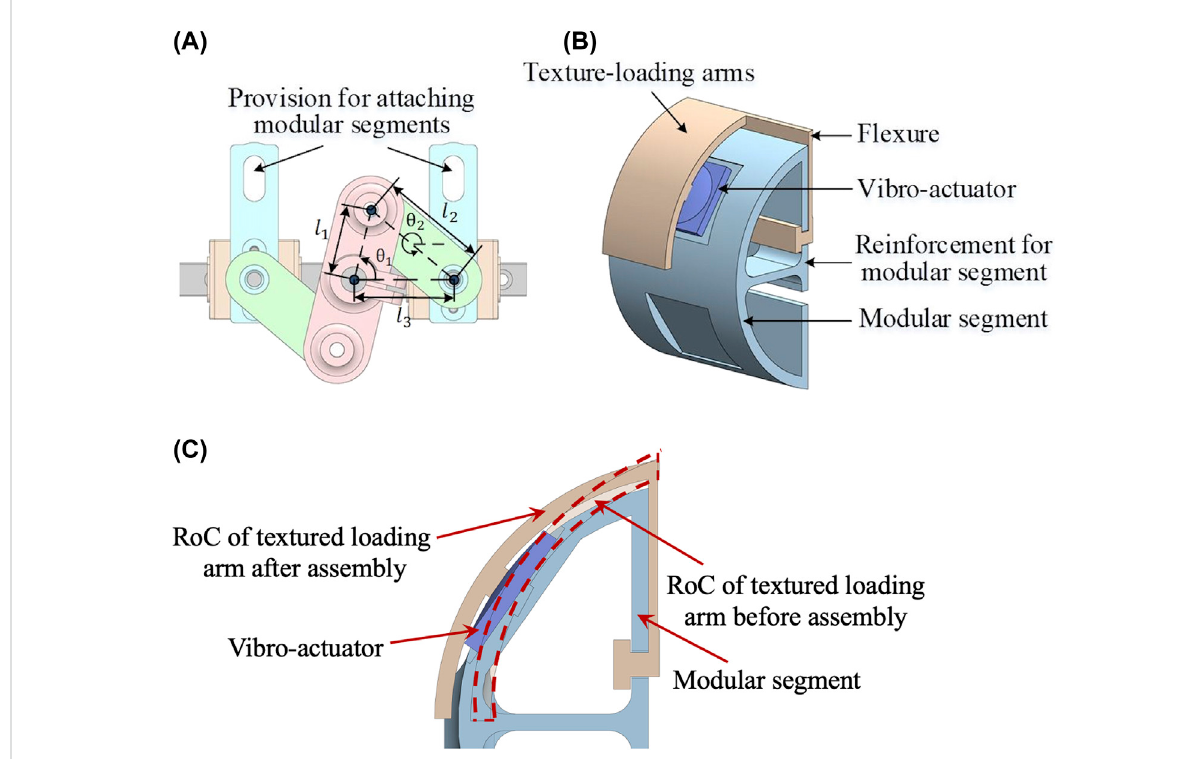
FIGURE 5 (A) Four-bar mechanism (B) Partially sectioned view of the modular segment with texture-loading arms and vibro-actuator (C) Vibro-actuator preloading. Four-bar mechanism renders stiffness to the user through the lateral movement of segments. The segments are modular and can be swappable with various segments. The textural arm is 3D printed with a smaller radius of curvature (roc), and after the assembly, the roc increases to accommodate the vibro-actuator leading to its